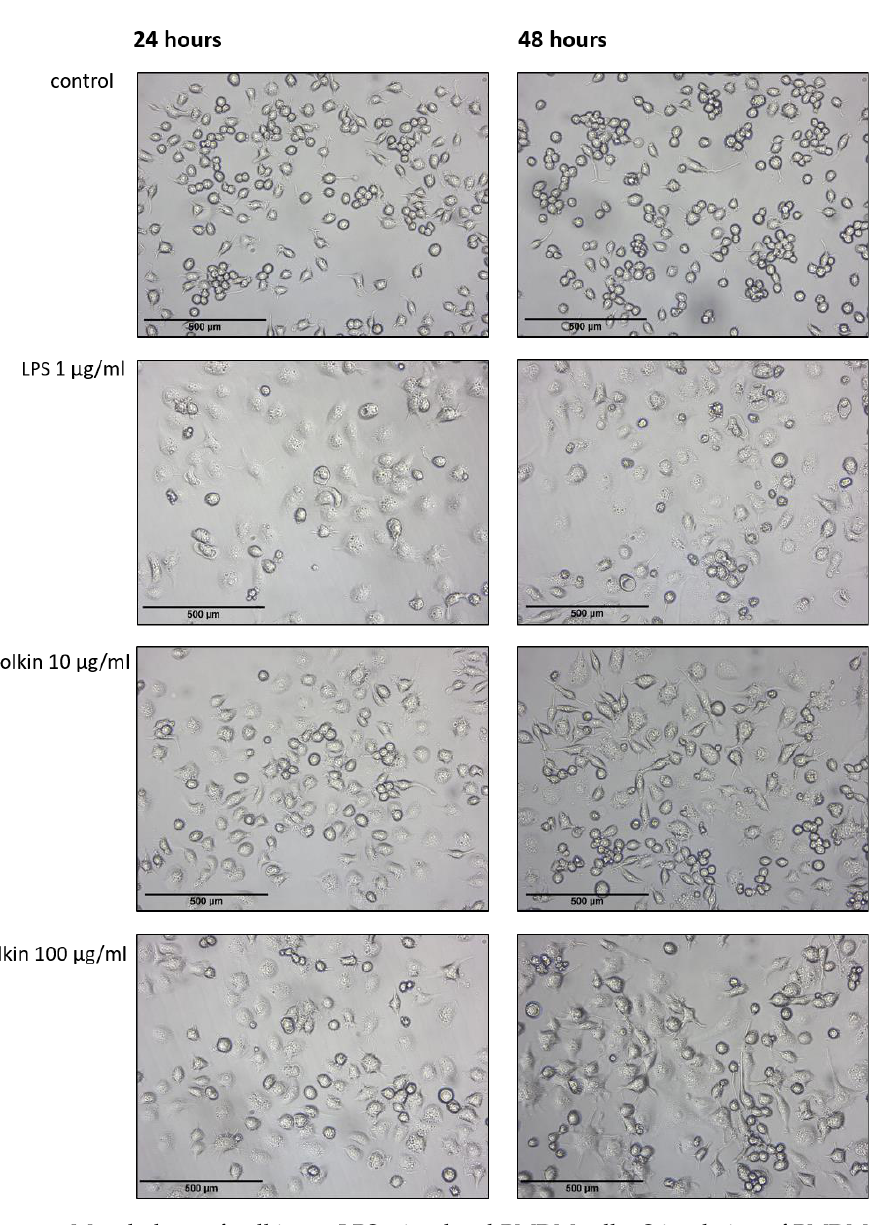
Figure 3. Morphology of yolkin- or LPS-stimulated BMDM cells. Stimulation of BMDM cells for 24 or 48 h with yolkin (10 and 100 µg/mL) or LPS (1 µg/mL) induced morphological changes that were visible under a light microscope with 4x lenses. The cells in the control group showed a round- shaped morphology, which changed after exposure to LPS or yolkin, where more spindle-shaped cells were presented. The cells were examined via light microscopy (Leica DM FRE2, bright field). One representative experiment is shown in this figure. Scale bars represent 500 microns.